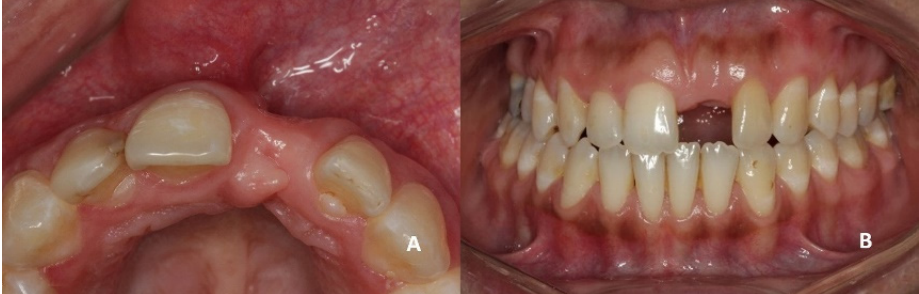
Figure 1. ( A , B ) Initial presentation of a patient wearing a removable partial prosthesis replacing a missing left upper central incisor.